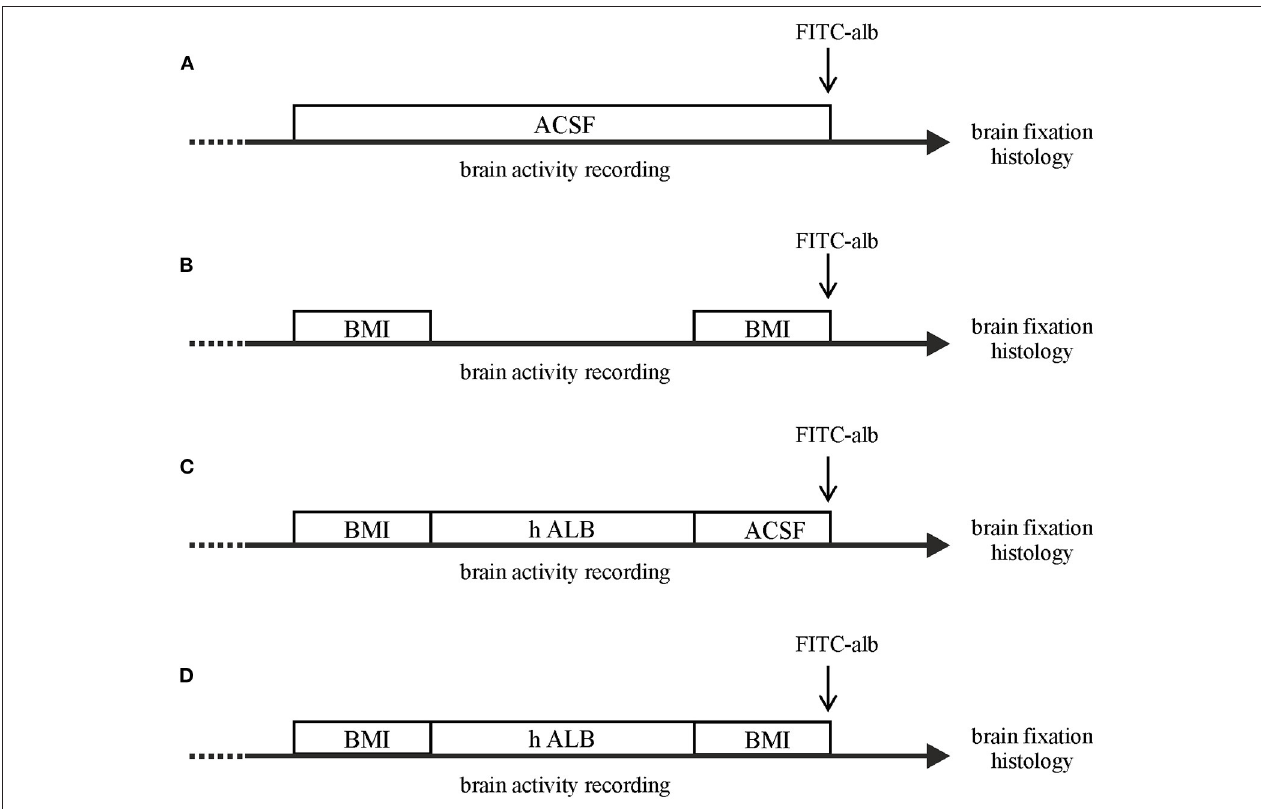
FIGURE 1 | Schematic drawing of the different experimental protocols utilized in the study. The in vitro brains were arterially perfused with: (A) control saline solution; (B) a double 3-min bolus of BMI; (C) 30-min perfusion with h-recombinant albumin (h-ALB) after the birst bolus of BMI; (D) 30-min perfusion with h-recombinant albumin (h-ALB) interposed between two boli of BMI. At the end of each experiment the brain was perfused with FITC-albumin for 4min to evaluate BBB leakage. Each experimental protocol lasted